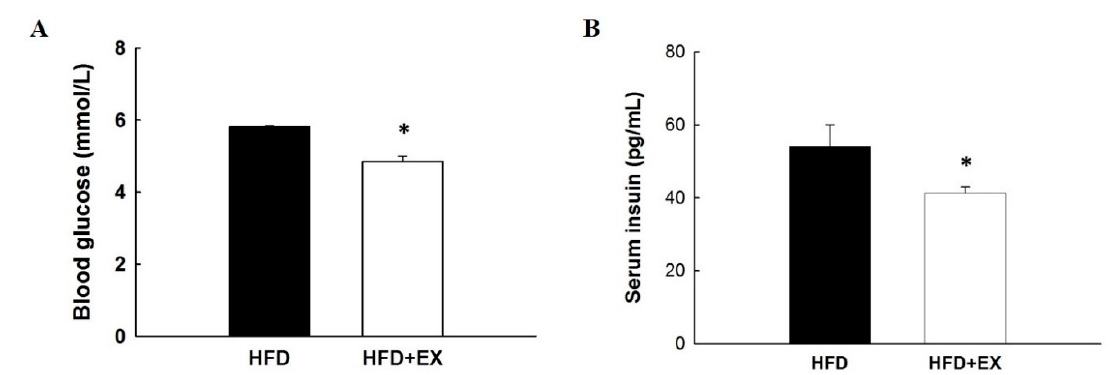
Figure 2. Effect of exercise in mice fed with a HFD on ( A ) blood glucose levels and ( B ) serum insulin levels. All values are given as mean ± SEM, n = 8 for all groups. Statistically significant at * P < 0.05.